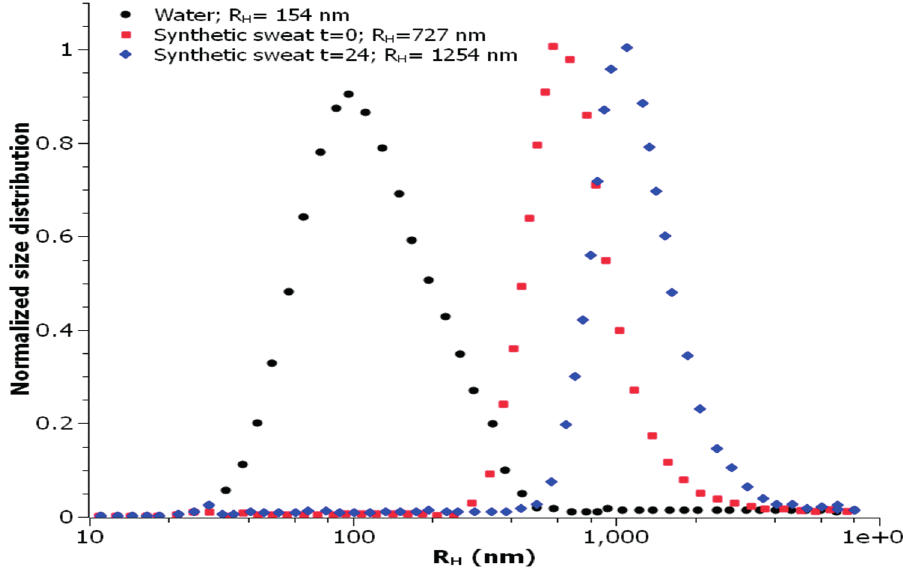
Figure 2. Size distribution of TiO 2 NPs in water and synthetic sweat suspension, estimated by DLS (Dynamic Light Scattering).